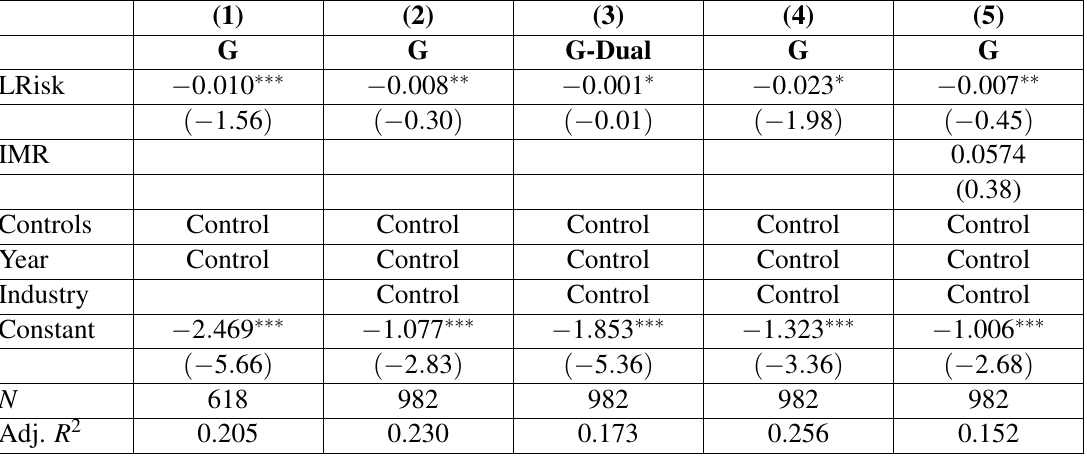
Table 7 Endogeneity and robustness